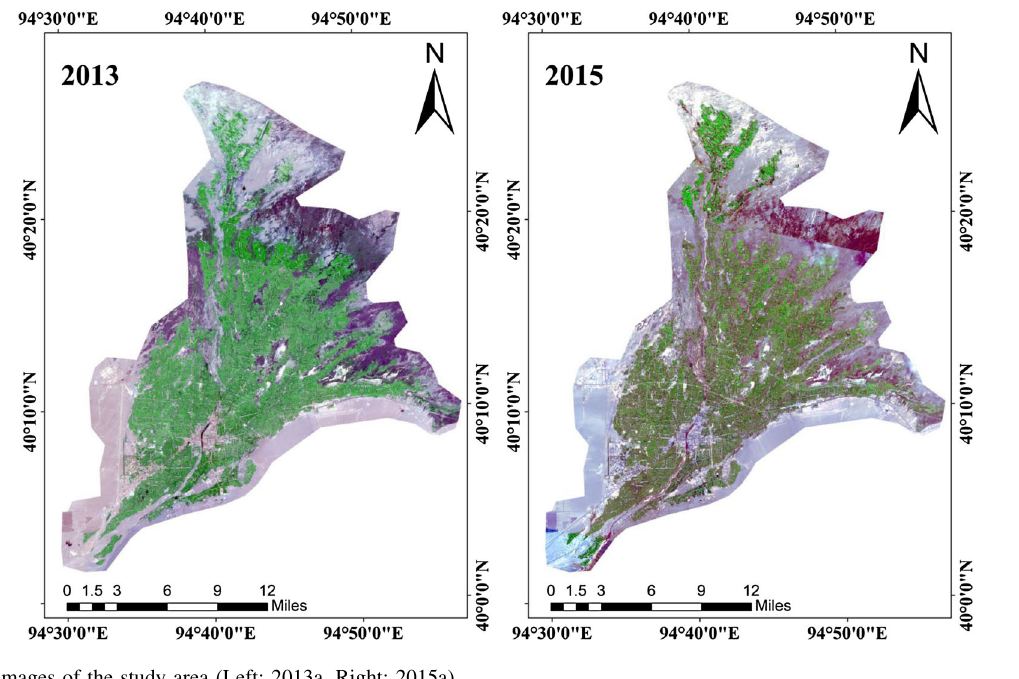
Fig. 2 GF-1 images of the study area (Left: 2013a, Right: 2015a)